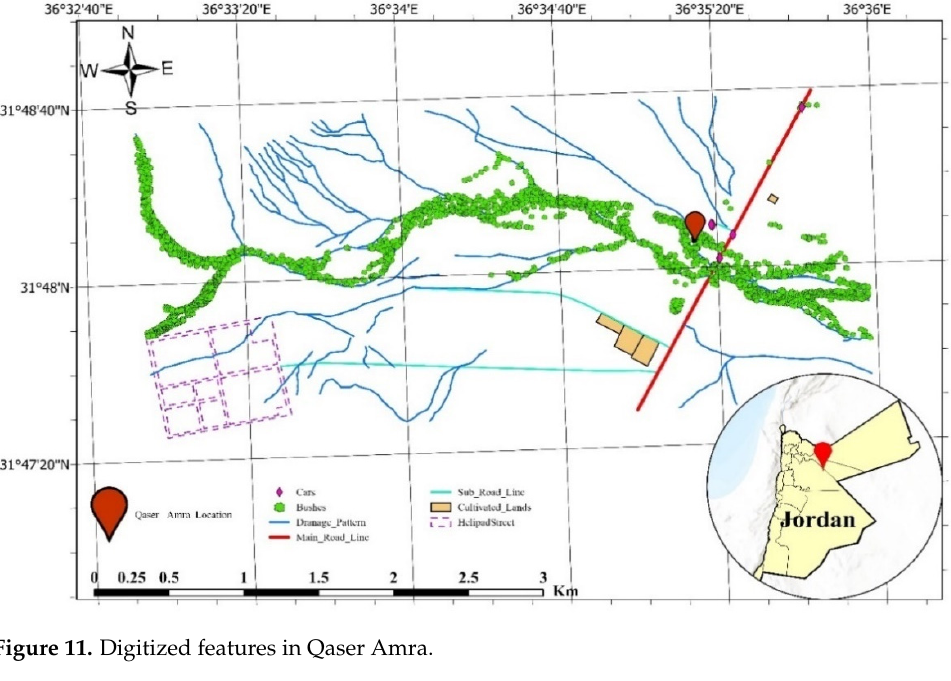
Figure 11. Digitized features in Qaser Amra.